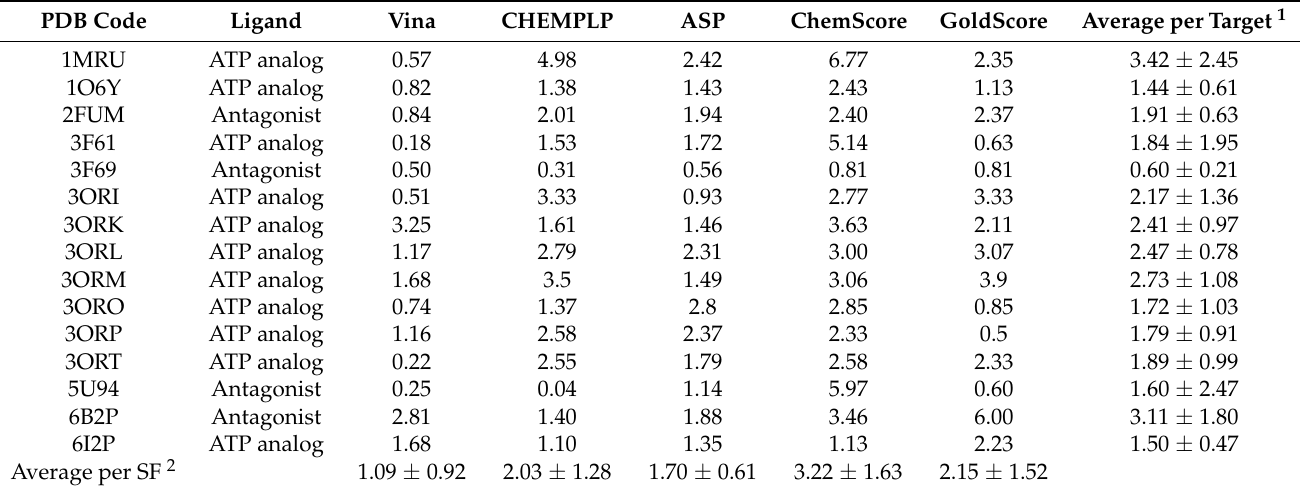
Table 2. Re-docking RMSD (Å) values for the all the PknB structures for all the docking programs used. PDB